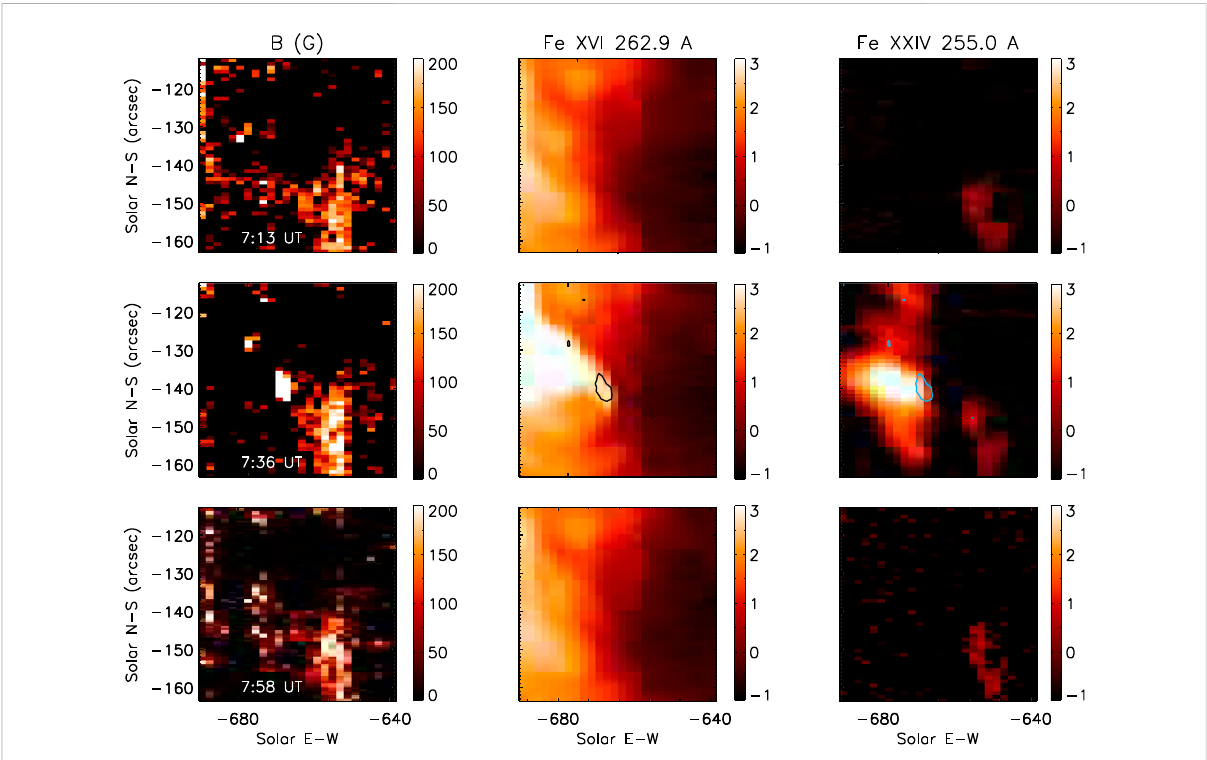
FIGURE 1 Maps of the magnetic fi eld strength B (left column), and of the intensity (log 10 values, in erg cm − 2 s − 1 sr − 1 ) of the Fe XVI 262.9 Å line (center column)andFeXXIV255.0 Åline(rightcolumn)asobserved22 minbeforetheC2.0 fl areon24Aug2007(toprow),duringthe fl are(middlerow),and afterthe fl are(bottomrow).Inthemiddlerow,themagnetic fi eldstrengthstrongerthan250 GissuperimposedasacontourplotintheFeXVIandFe XXIV images during the fl